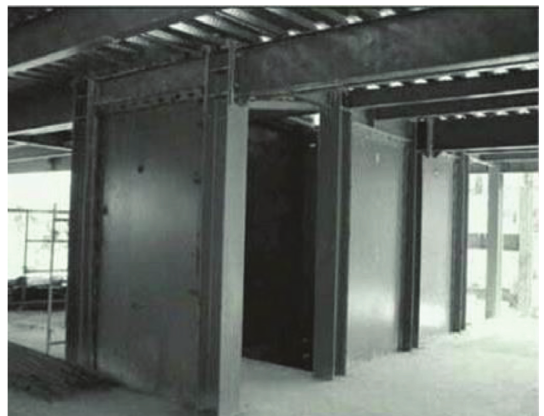
Figure 1: Executing steel shear wall.